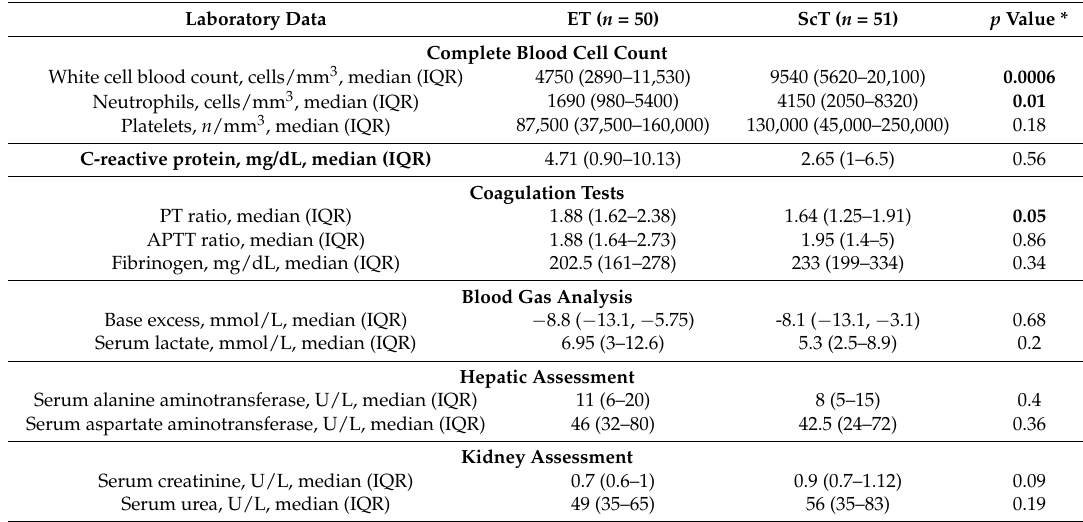
Table 4. Laboratory evaluation in the study population at the onset of septic shock.